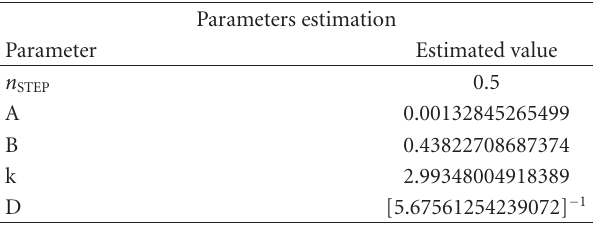
Table 3: The estimation of the parameters for the forecasting mod-